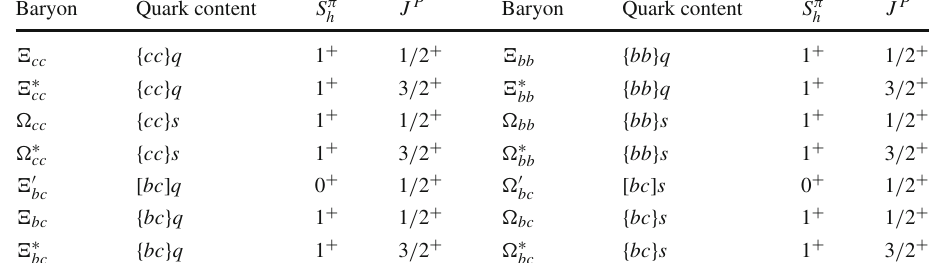
Baryon Quark content